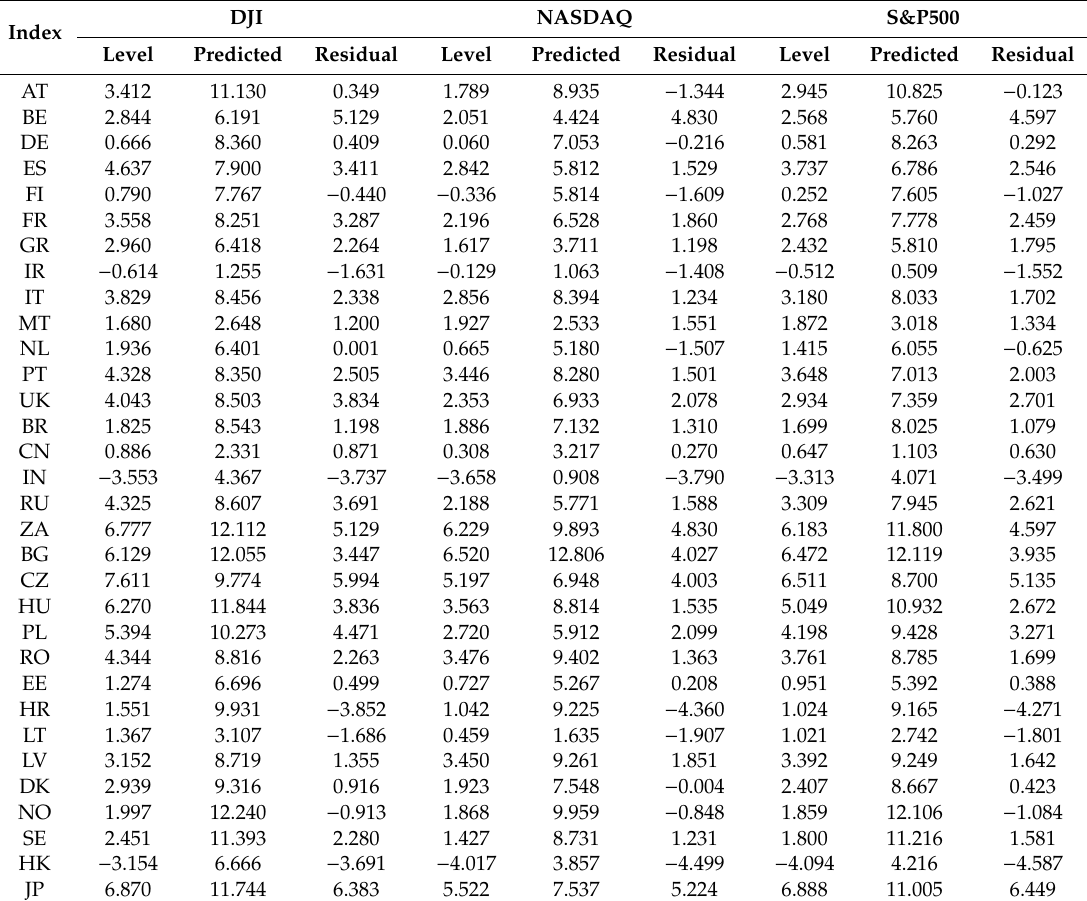
Table 4. T-test for Contagion of GFC for lag Level, Predicted and Residual Series and DJI, NASDAQ and S&P500 are sources of